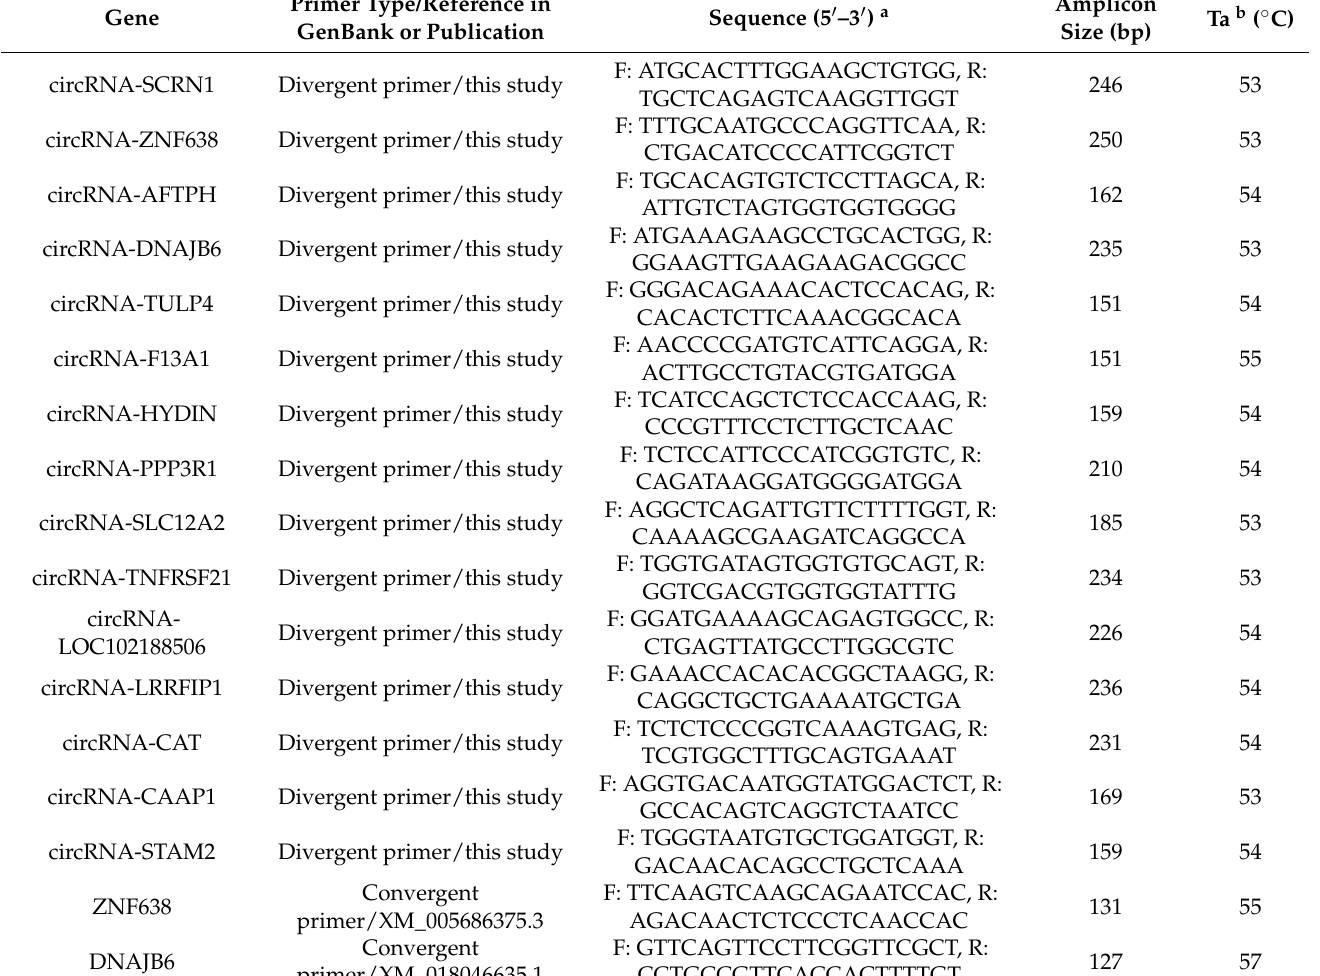
Table 1. Details of the primers used in this study and their real-time PCR reaction